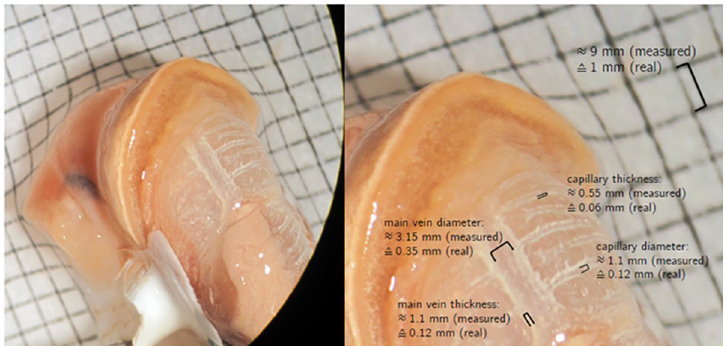
Fig 8. External view on the dissected lung and measurement of vein